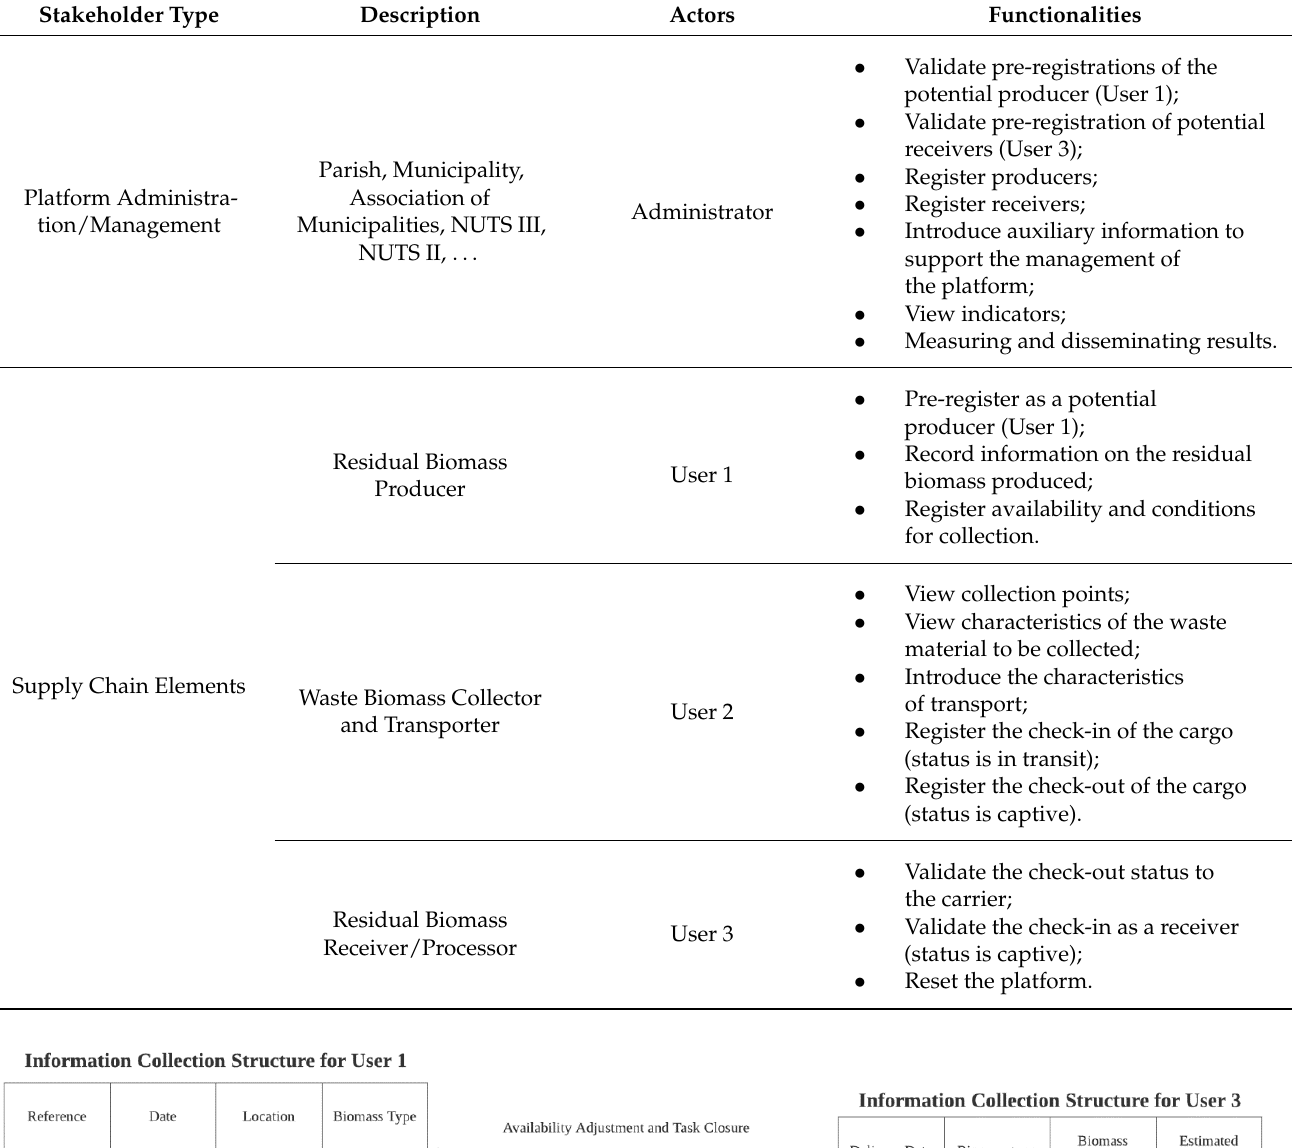
Table 4. Types of stakeholders and their functionalities.